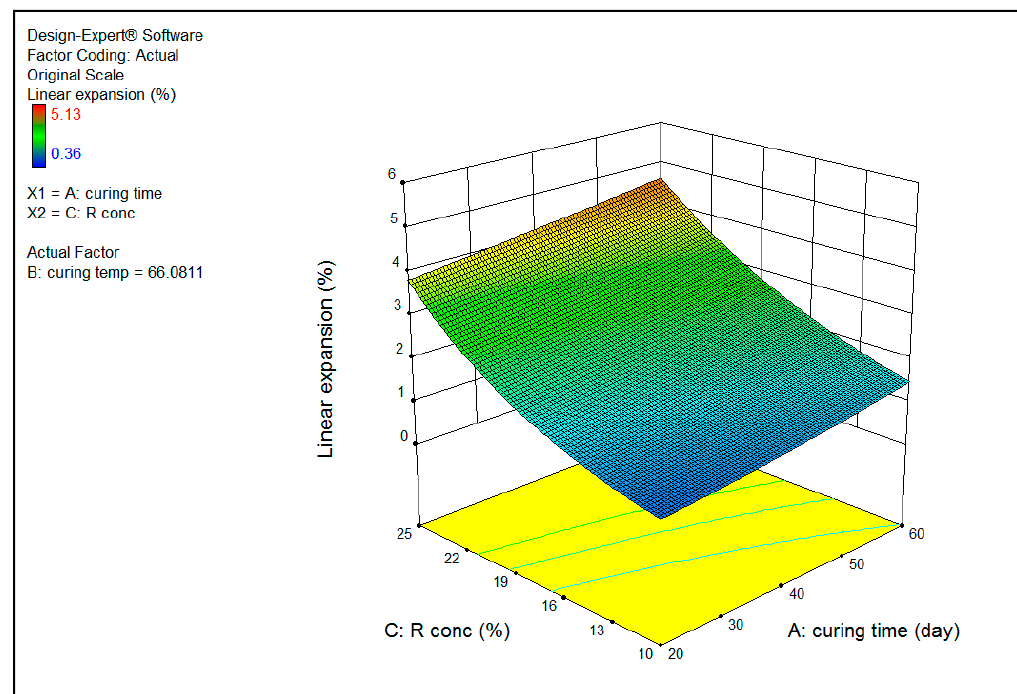
Figure 12. 3D Plot for linear expansion at 81°C curing temperature.